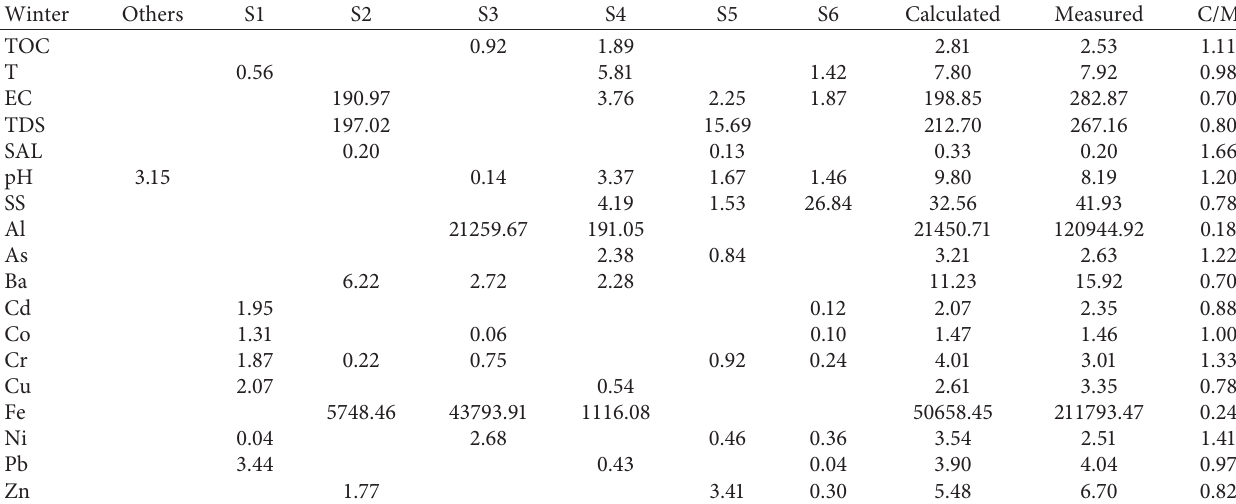
Table 3: Source apportionment for physicochemical parameters and heavy metals in